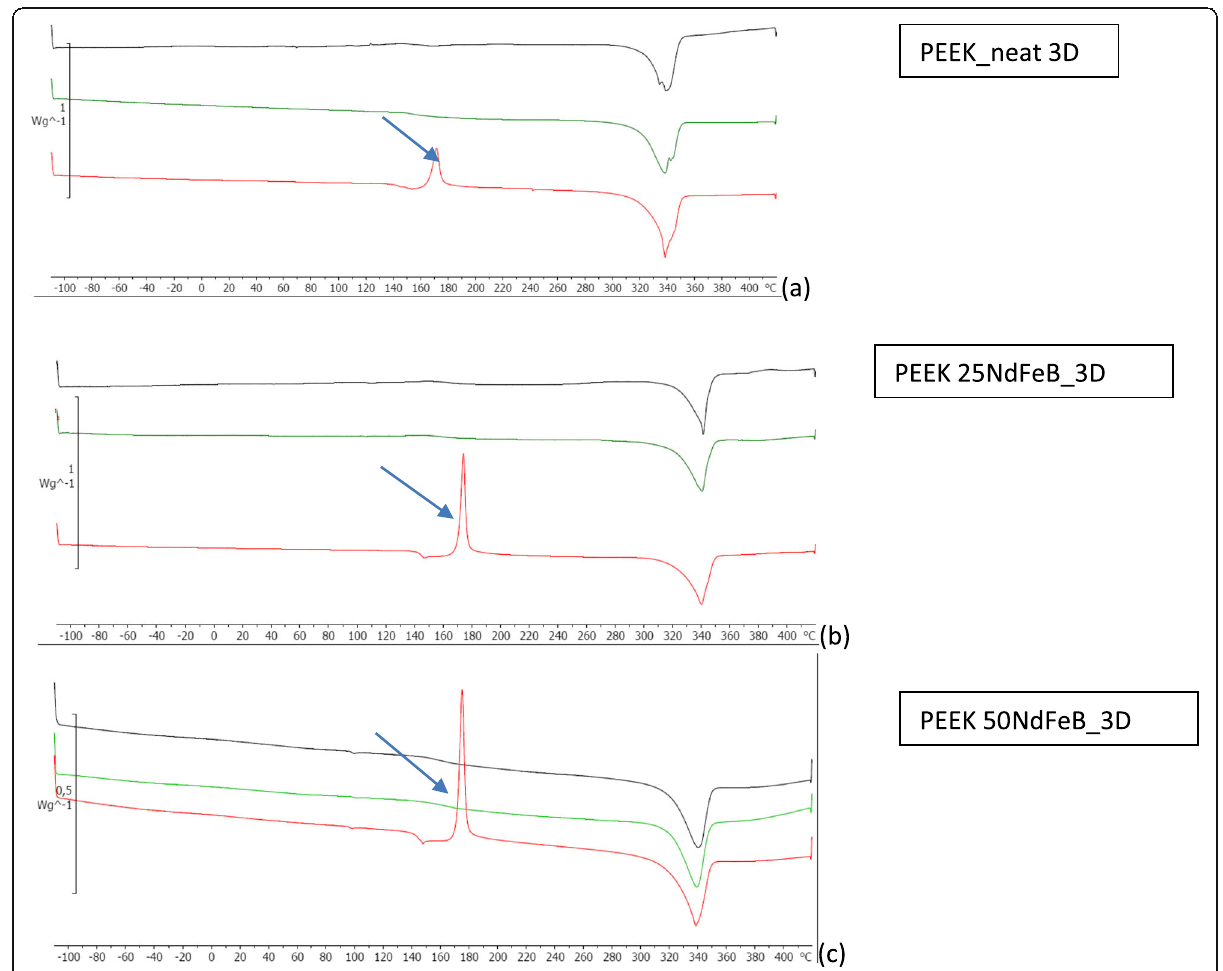
Fig. 9 DSC first heating curves for bottom (red line), middle (green line) and top (black line) layer of 3D printed parts a neat PEEK